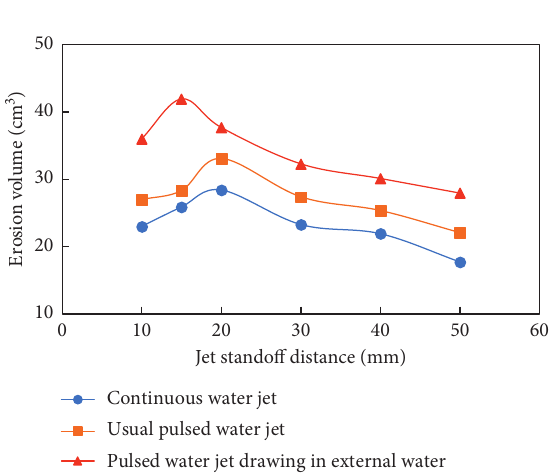
Figure 4: Effect of jet standoff distance on the erosion performance (when the pump pressure is 15MPa).